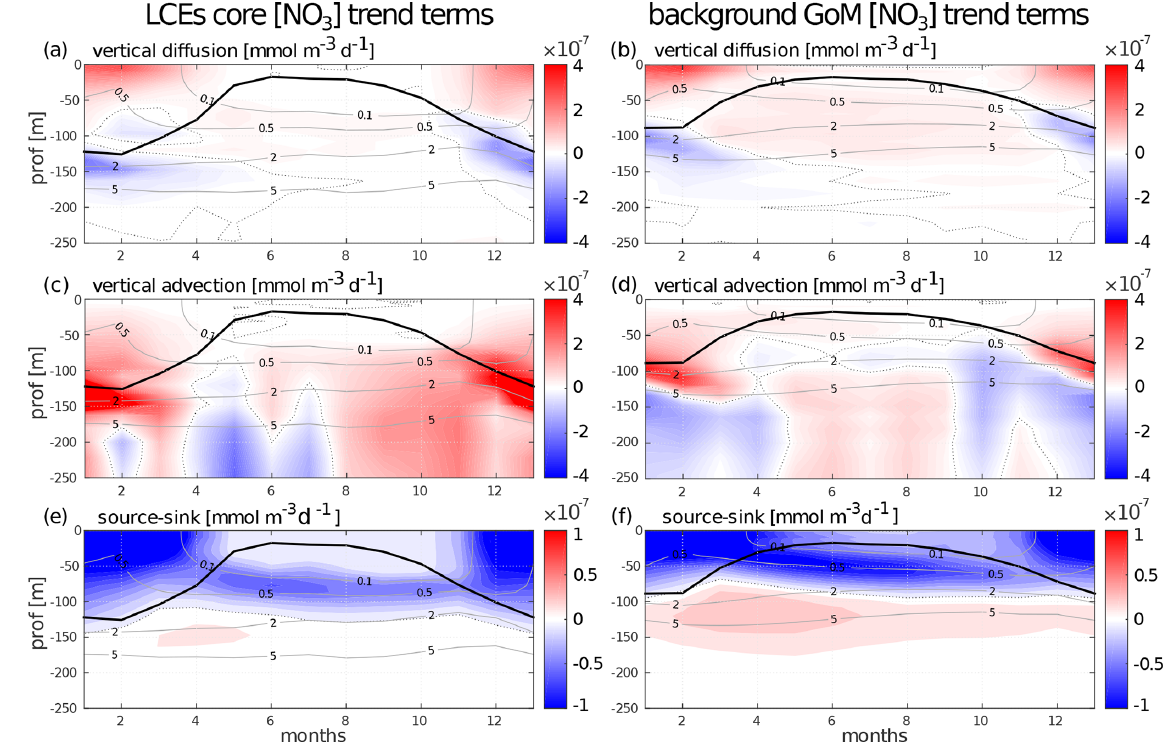
Figure B1. Seasonal cycle of nitrate trend terms in the (a, c, e) LCE core and in the (b, d, f) background GoM. The trend induced by (a, b) vertical mixing, the (c, d) vertical advection, and the (e, f) biogeochemical source minus sink is represented. Isopycnal anomalies (gray contours) and the depth of the mixed layer (black line) are